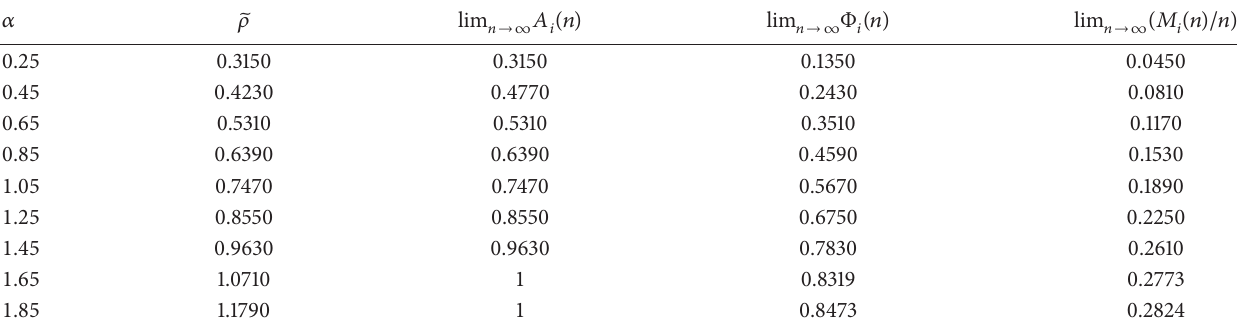
Table 3: The effects of unpredictable events arrival rate 𝛼 on IP controller (𝑝 = 0.15, 𝑛 = 1)